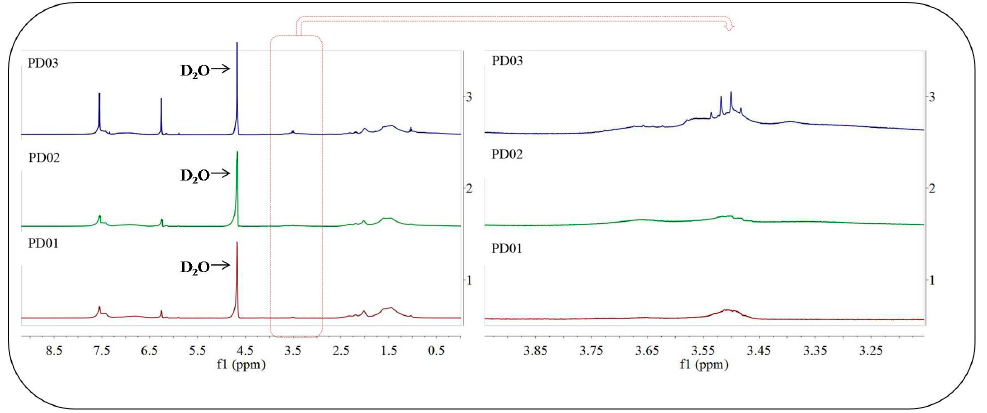
Figure 4. The 1 H-NMR spectrum of water-based dispersant PD0x. Table 2. Elemental analysis results of dispersant PD0x.